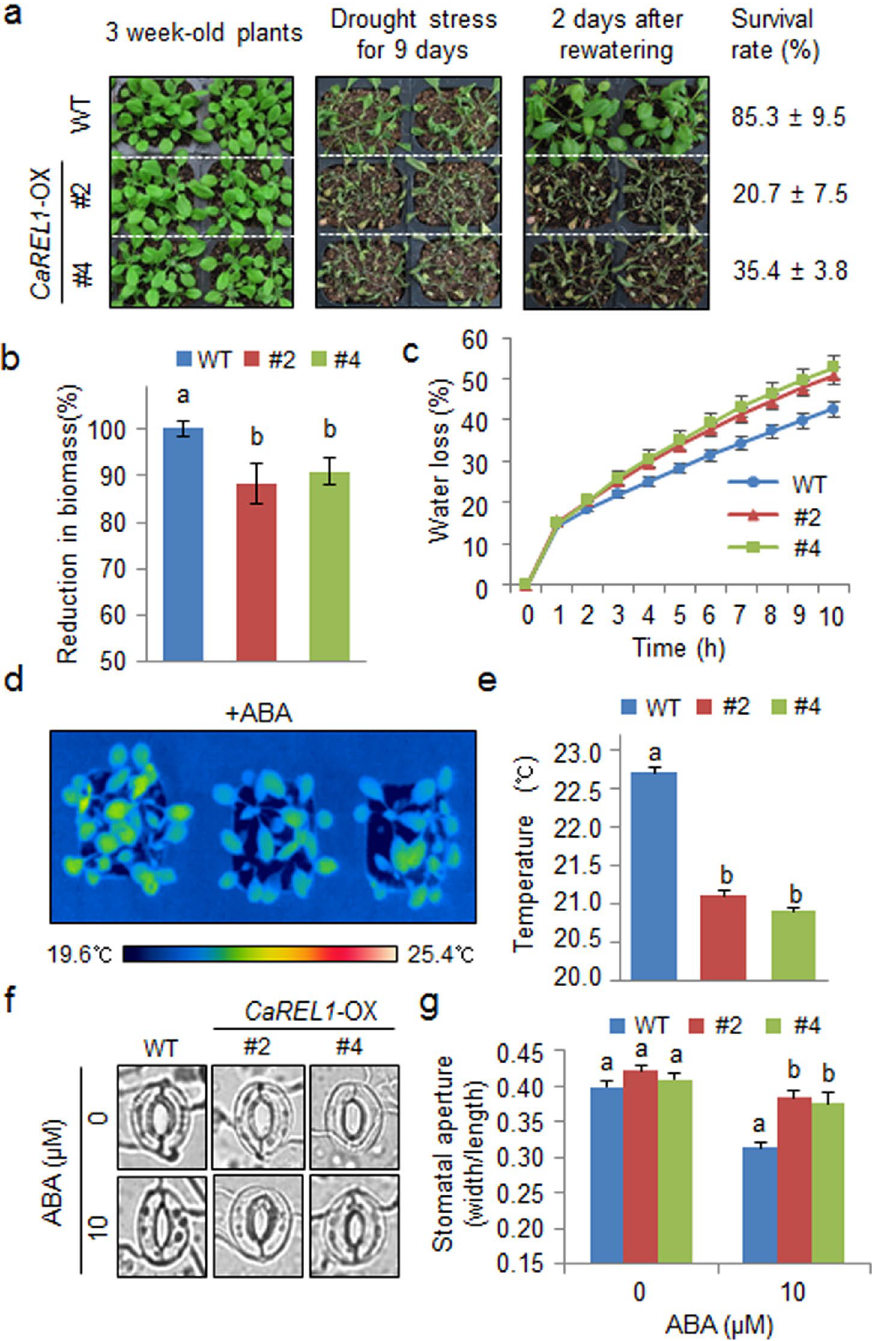
Figure 5. Reduced tolerance of CaREL1- OX plants to drought stress. ( a ) Drought tolerance of CaREL1- OX transgenic plants. Three-week-old wild-type and transgenic plants were subjected to drought stress by withholding water for 9 days and then re-watering for 2 days. Survival rates of plants were measured after re- watering. ( b ) Reduced biomass of CaREL1- OX plants. The plant biomass was measured after re-watering. ( c ) Transpirational water loss from the leaves of wild-type and transgenic plants at various times after detachment of leaves. ( d and e ) Decreased leaf temperatures of CaREL1- OX plants in response to ABA treatment. Leaf temperatures of plants treated with 50 μ M ABA were measured using thermal imaging and representative images were taken ( d ). Data represent the mean ± standard error of three independent experiments ( e ). ( f and g ) Stomatal apertures in wild-type and CaREL1 -OX plants treated with ABA. Leaf peels were harvested from 3-week-old plants of each line and incubated in SOS buffer containing 0 μ M or 20 μ M ABA. Stomatal apertures were measured under the microscope and representative images were taken ( e ). Data represent the mean ± standard error of three independent experiments ( f ), each evaluating 20 plants. Different letters indicate significant differences between wild-type and transgenic lines ( P < 0.05; ANOVA followed by Fisher’s LSD